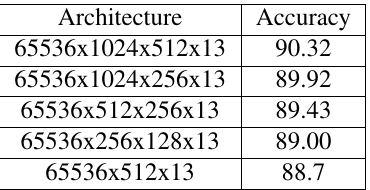
Table 1. List of architecture and their